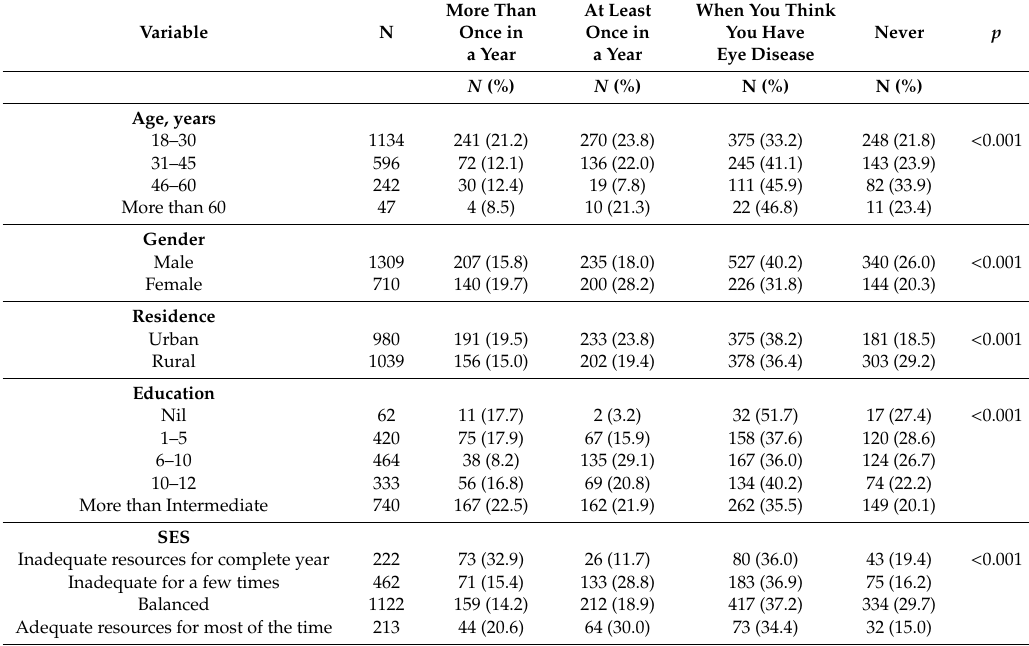
Table 6. Association of demographic characters with practice regarding eye check. Variable N